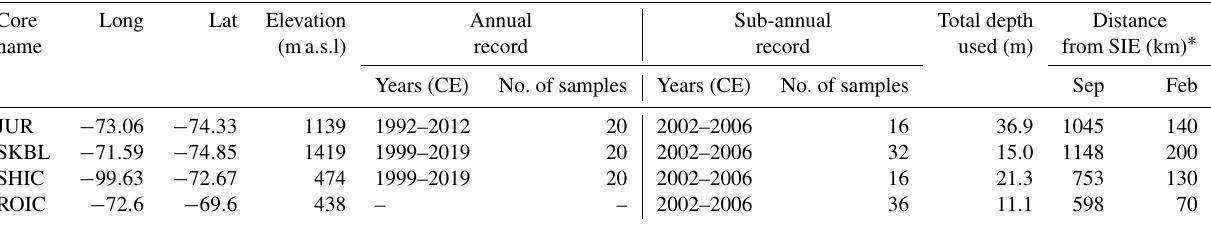
Table 1. Summary of each ice core geographical location and main features of the datasets analysed in this study. SIE: sea ice edge( ∗ ) – the distance from SIE reported corresponds to the median for years covering the data interval (see Sect. 3.3). September SIE values used for calculations were obtained as the distance between the ice core site and the closest point in the northern limit of 15% sea ice cover. February SIE values used for calculations were obtained as the distance between the ice core site and the closest sea-ice-free region.